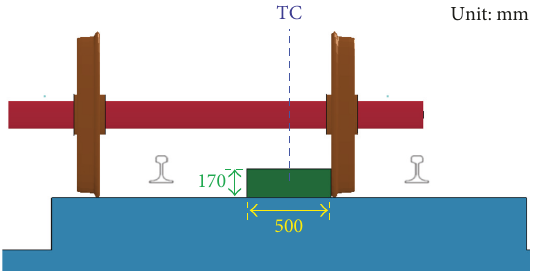
Figure 23: Overview of the containment wall (or block) within track